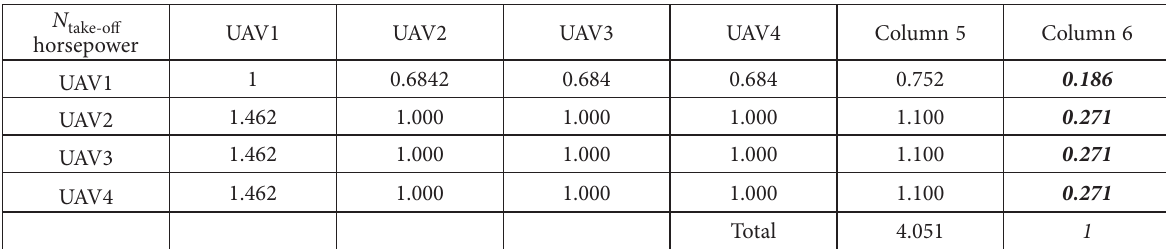
Table 14. Local priorities of UAVs according to their parameters